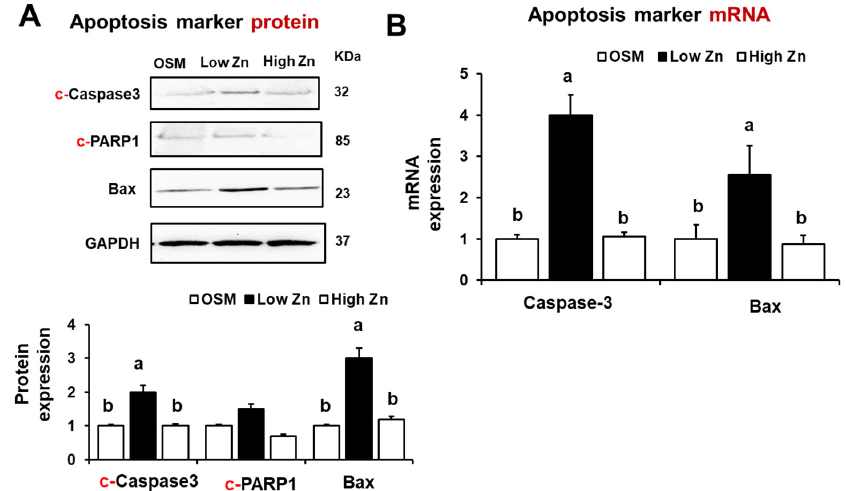
Figure 7. Apoptosis marker proteins induced by low Zn in MC3T3-E1 cells. OSM is the normal